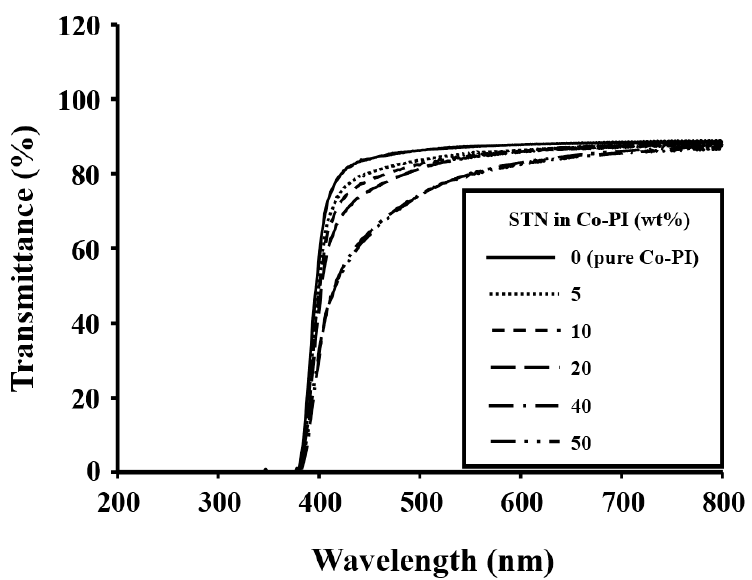
Figure 11. UV-vis transmittances of the Co-PI hybrids with various STN concentrations. Table 6. Optical properties of the Co-PI hybrid films with varying STN concentrations.